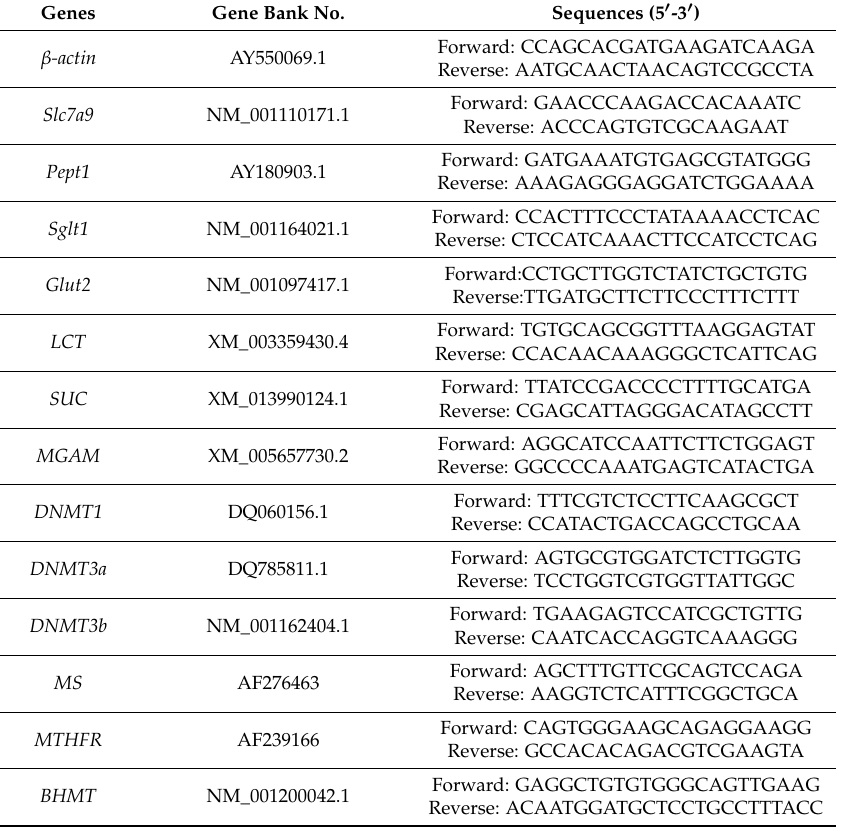
Table 2. Oligonucleotide primers used for a relative-quantitative real-time PCR analysis. Genes Gene Bank No. Sequences (5 (cid:48) -3 (cid:48)